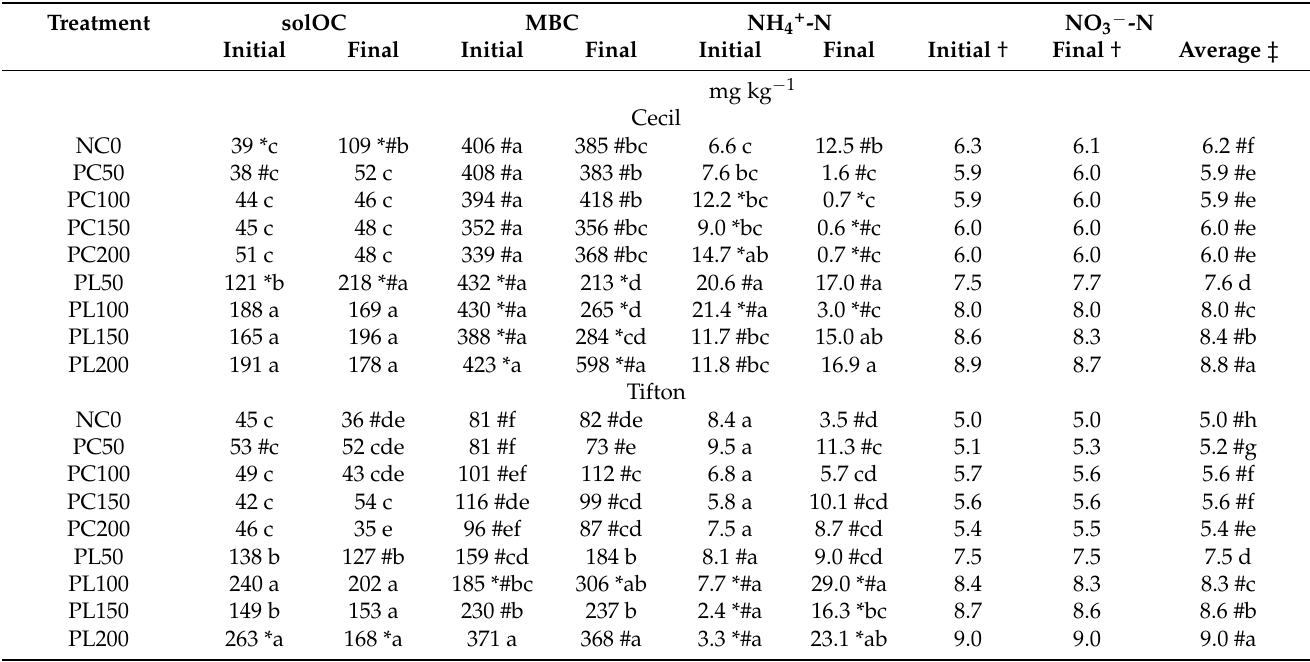
Table 4. Means of soluble OC (solOC), microbial biomass C (MBC), NH 4+ -N, and NO 3 − -N show- ing simple main effects analyzed within the significant three-way interactions of time*soil and type*treatment. Treatments were no char (NC), pine chip biochar (PC), or poultry litter biochar (PL) at different application rates, as